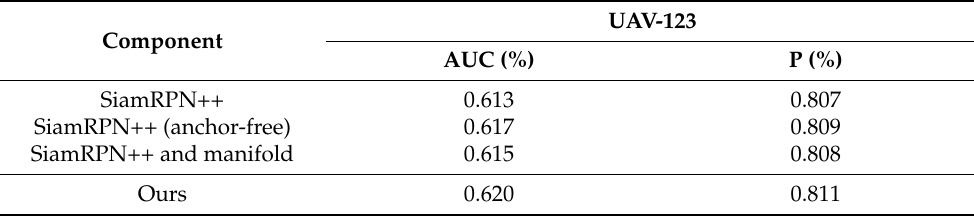
Table 3. The results of the ablation